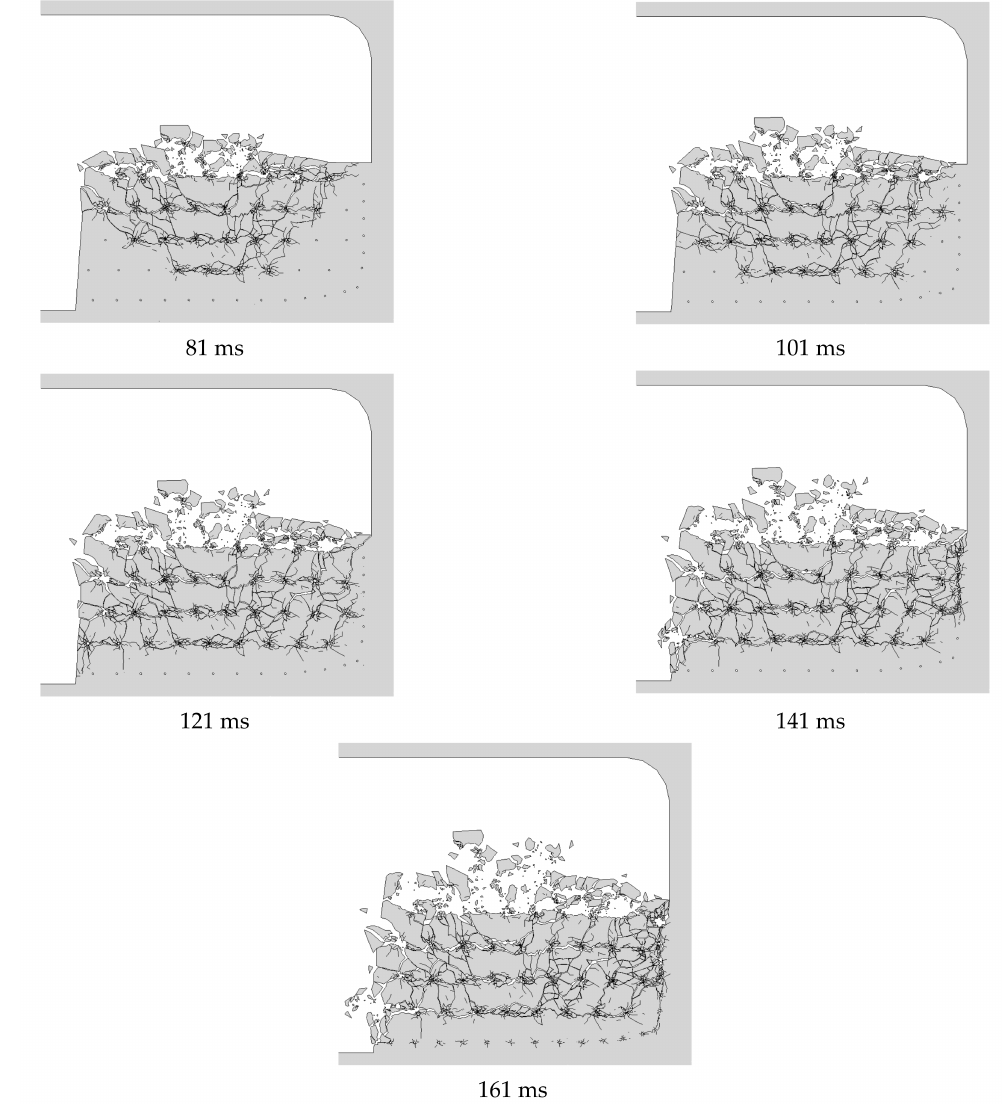
Figure 13. The process of rock damage and fracture in the CRD method.